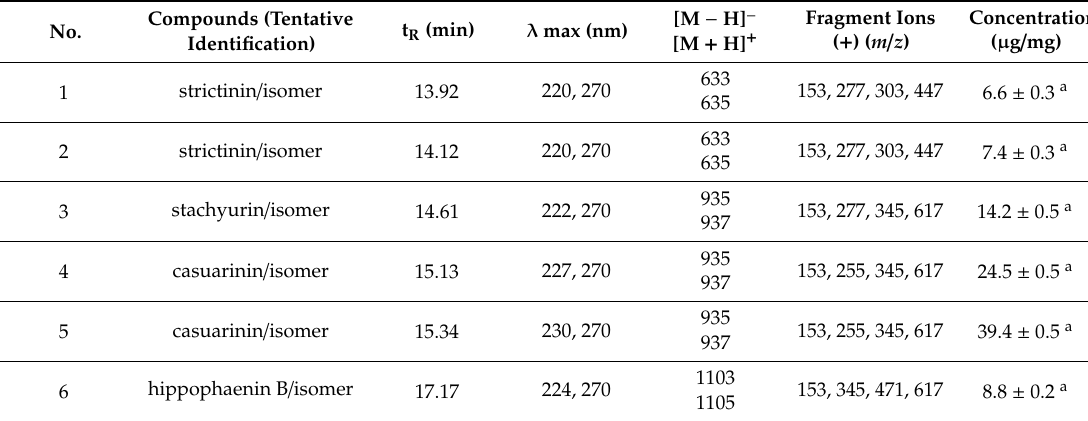
Table 2. Major phenolic compounds (above 5 µ g / mg) of the sea buckthorn leaf extract.